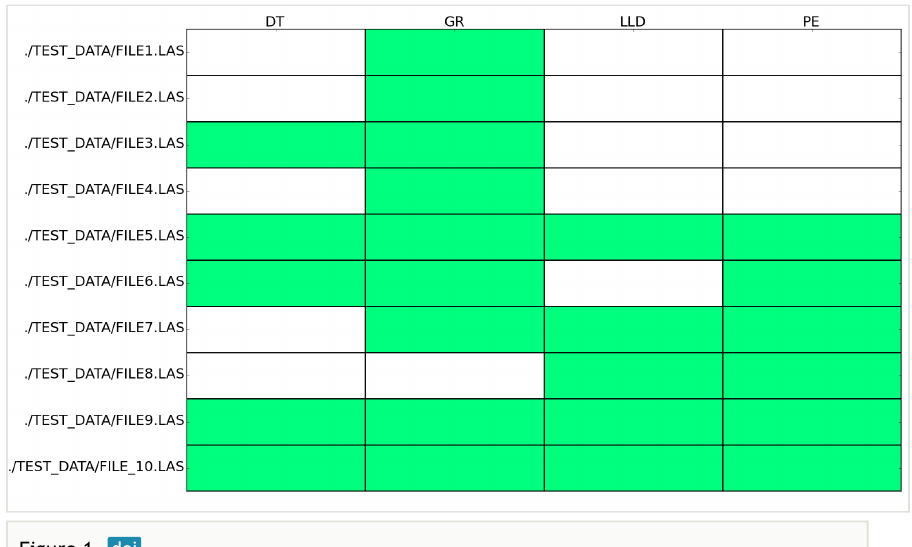
Figure 1. Graphical representation of logs present in several LAS fi les. The green color represents logs present and the white color represent logs which are not